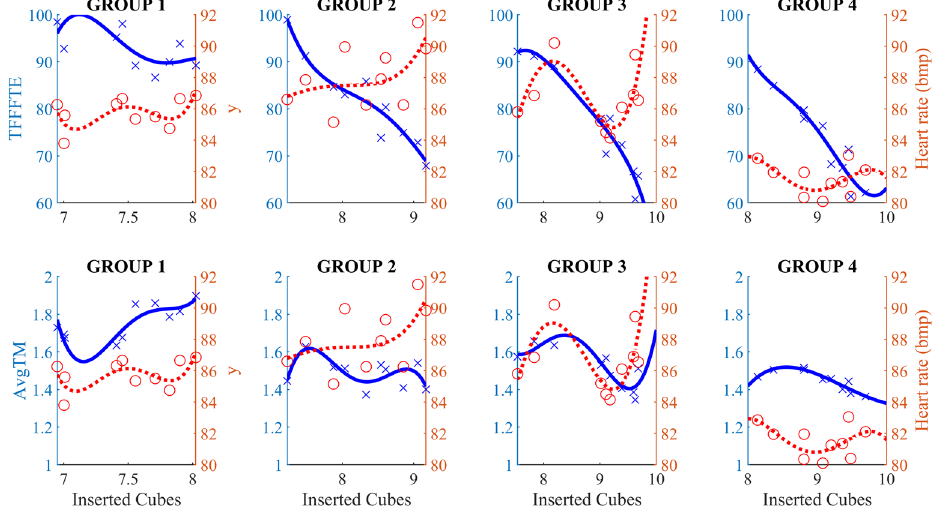
Figure 6. TfFTtE was substantially lower only in the groups (3, 4) that managed to complete the task with 9 or even 10 cubes inserted. However, it was obviously not easy for group 3 with much higher HR than group 4. The AToM was again higher in group 1 and shorter in group 4 with low HR.